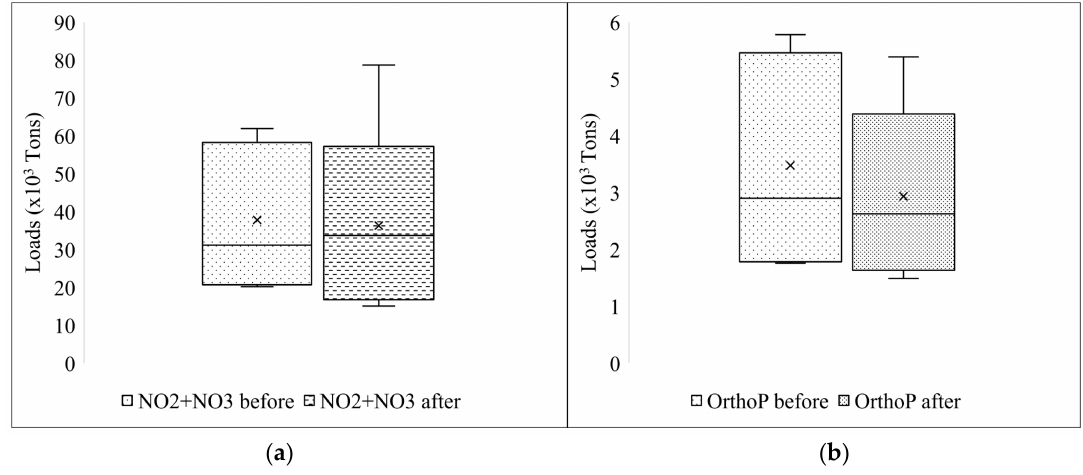
Figure 3. Comparison of nutrient loads before and after Hurricane Katrina in 2005 for ( a ) NO 2 − + NO 3 − and ( b ) orthophosphate. There is no statistically significant difference ( p > 0.05) between before and after Hurricane Katrina in 2005 for NO 2 − + NO 3 − . However, there is a statistically significant difference ( p < 0.05) between before and after Hurricane Katrina in 2005 for orthophosphate.